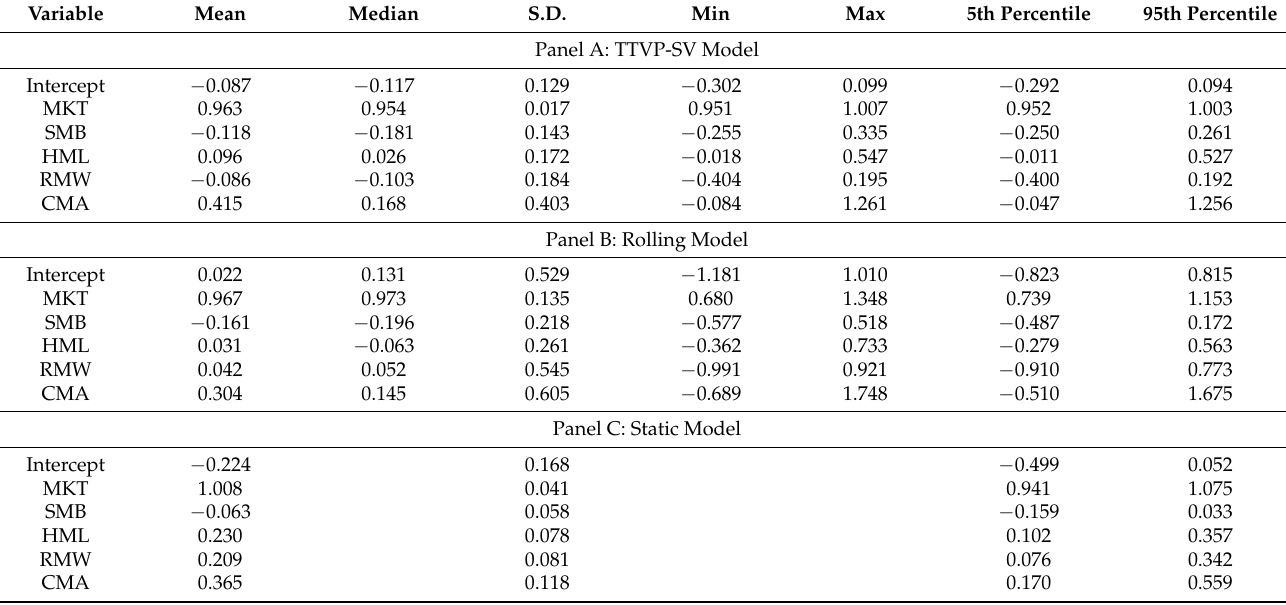
Table 4. Time varying, rolling and static factor